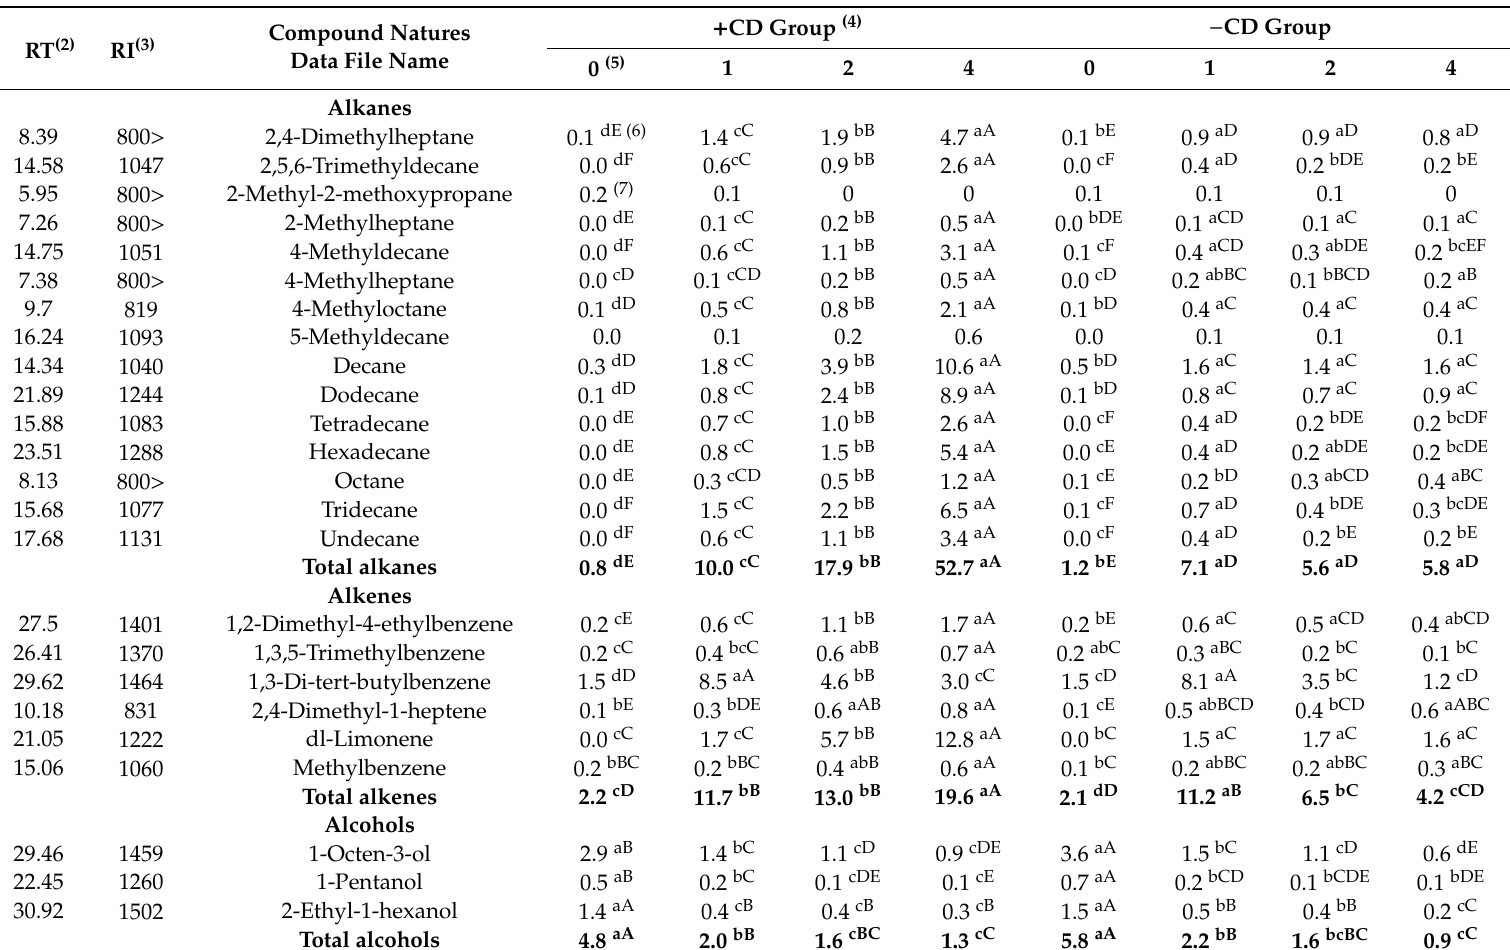
Table 1. Gas chromatography–mass spectrometry (GC–MS) results of volatile components as a ff ected by cyclodextrin in isolated soy protein (ISP) colloids with / without centrifuging